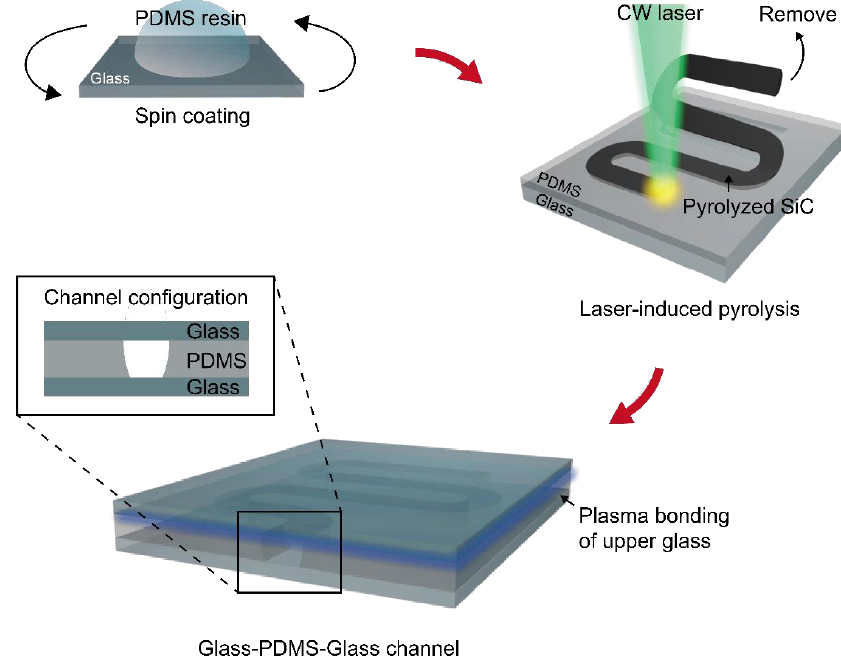
Figure 1. Concept illustration of the fabrication process.